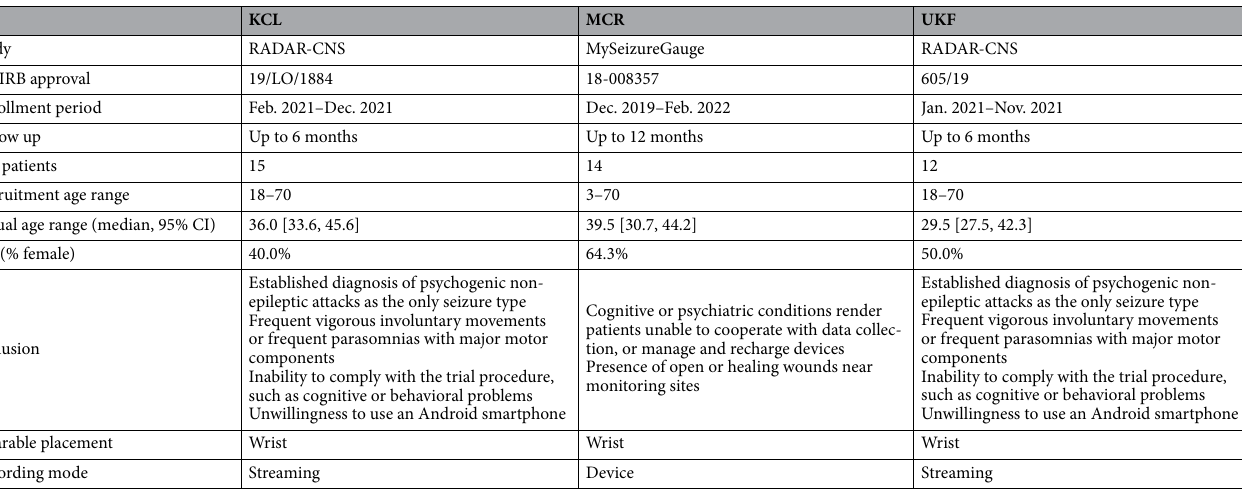
Table 2. Overview of outpatient ambulatory cohorts and recruitment. EC Ethics Committee, IRB Institutional Review Board.